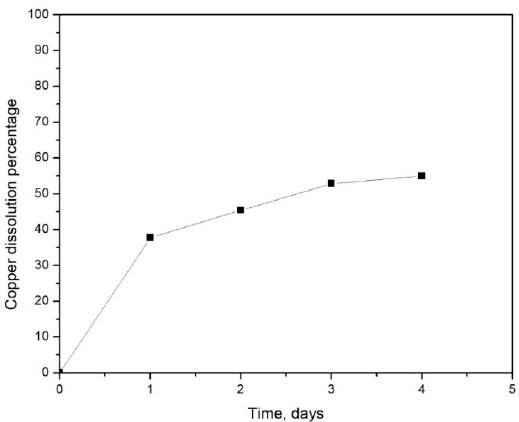
Figure 4 . Copper leaching of white metal with a leaching solution containing 20 g/L H 2 SO 4 at 1 atm, Figure 4. Copper leaching of white metal with a leaching solution containing 20 g / L H 2 SO 4 at 1 atm, 22 °C and 400 rpm. 22 ◦ C and 400 rpm.